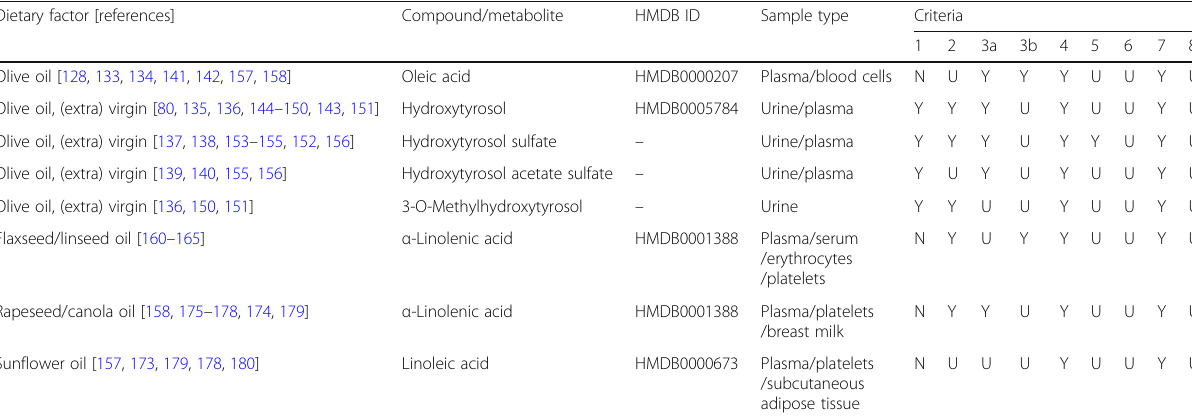
Table 4 Validation scheme of potential food intake biomarkers for vegetable oils Dietary factor